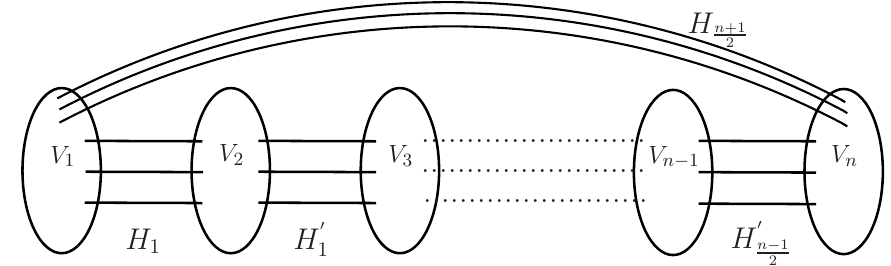
Figure 5. The graph G